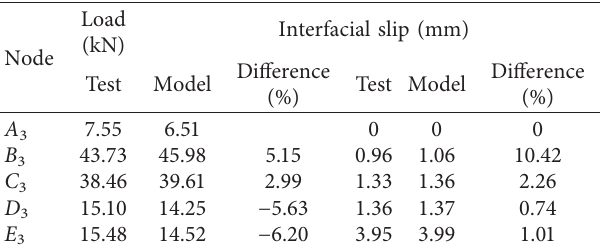
Figure 14: Comparison of model and test results. (a) CD-ERA-P- λ Table 7: Load-deflection curve and load-slip curve information of specimen CD-ERA-P- λ 4.44 .